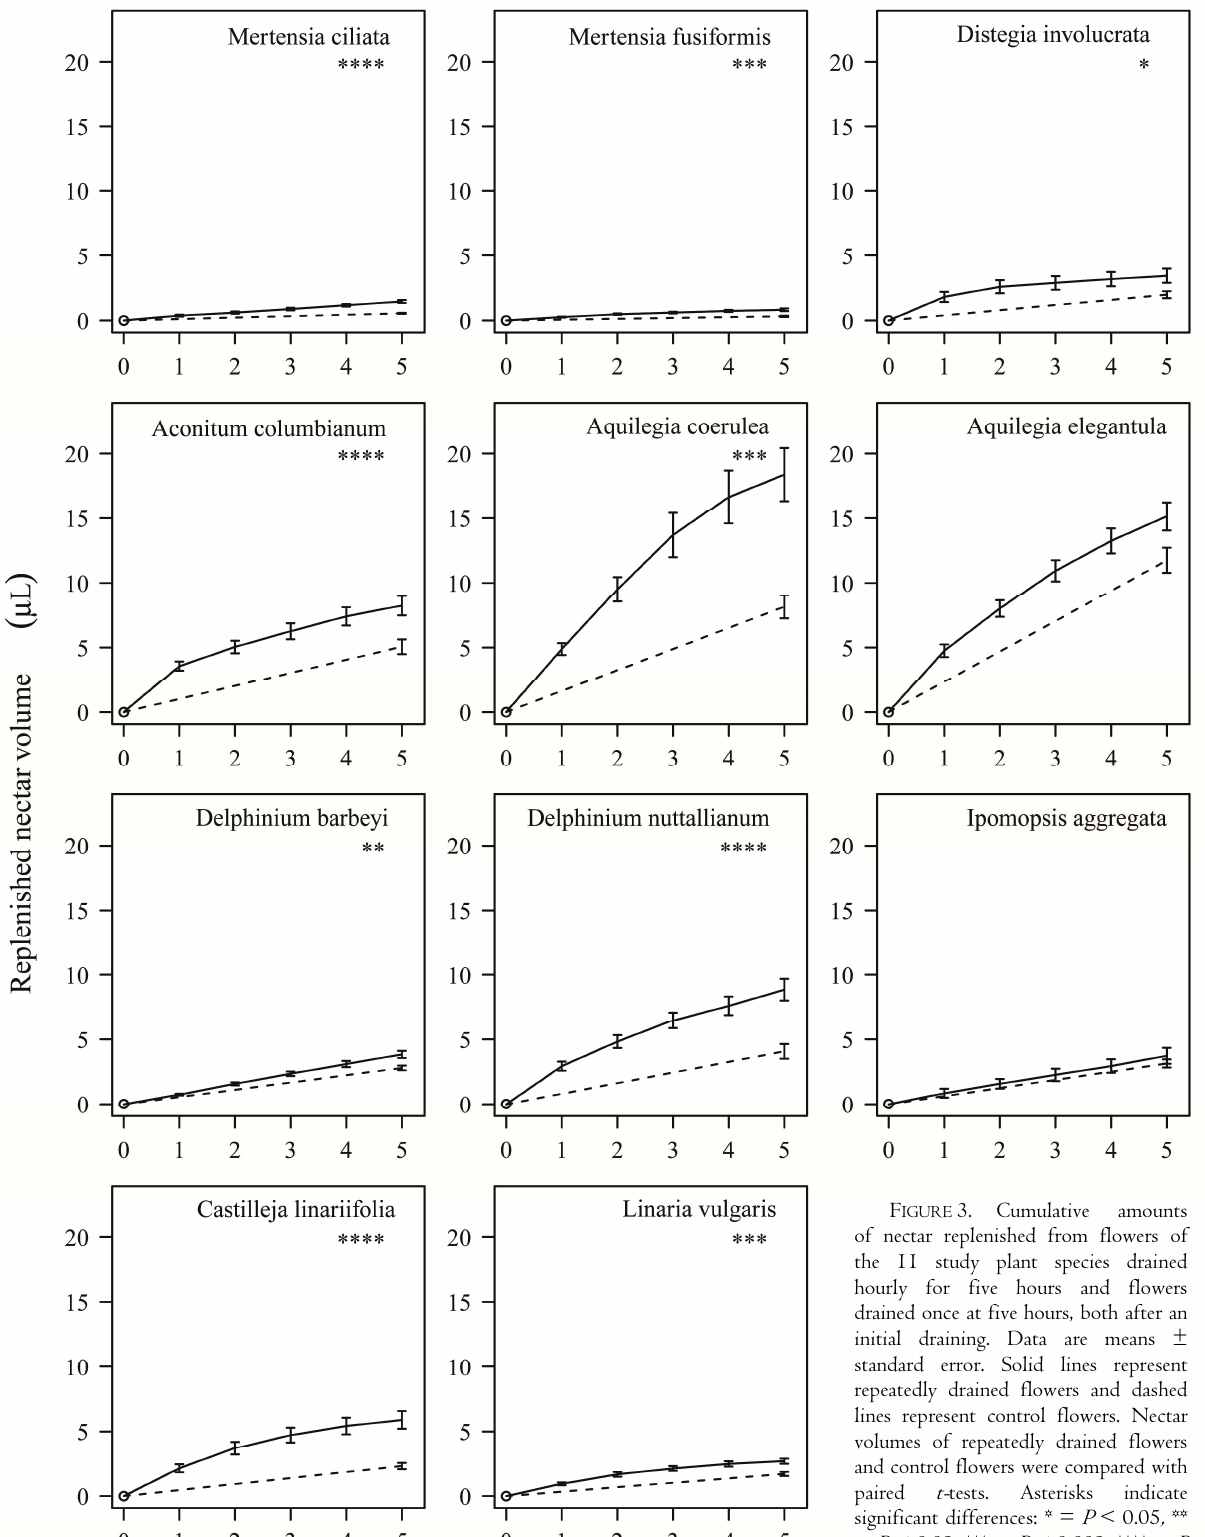
F IGURE 3. Cumulative amounts of nectar replenished from flowers of the 11 study plant species drained hourly for five hours and flowers standard error. Solid lines represent repeatedly drained flowers and dashed lines represent control flowers. Nectar volumes of repeatedly drained flowers